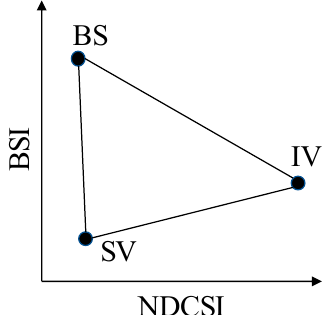
Figure 8. The conceptual approach for quantifying illuminated / shaded vegetation fractional cover using Sentinel-2A multispectral data, whose reflectance spectra form a triangle in the scatterplot of NDCSI versus BSI. Pure endmembers reflectance spectra of IV, SV and BS will be located in the vertices of the triangle. Reflectance spectra of mixed pixels of the three components will be located within the triangle.